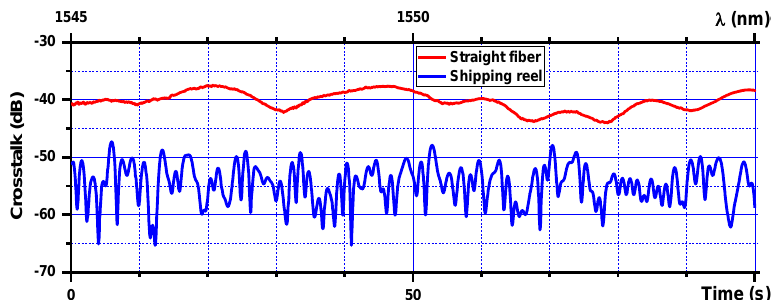
Figure 17. Crosstalk variations with laser wavelength scanning for straight and reeled fiber of a 100 m length.